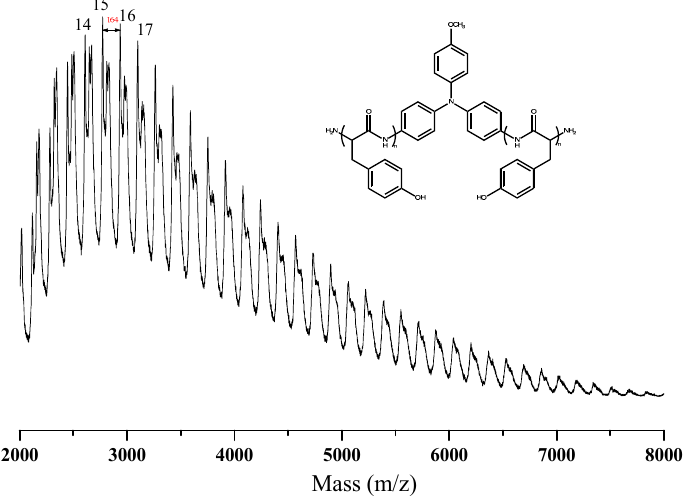
Figure 4. MALDI-TOF mass spectral analyses for PTyr-TPA.